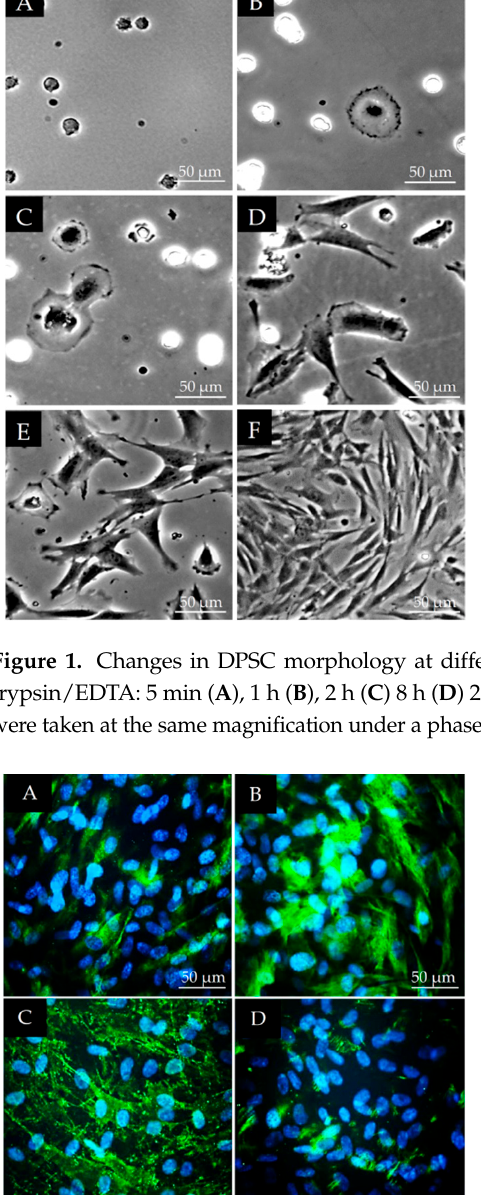
Figure 1. Changes in DPSC morphology at different stages of cell adhesion after passaging with trypsin/EDTA: 5 min ( A ), 1 hour ( B ), 2 hours ( C ) 8 hours ( D ) 21 hours ( E ) and 3 days ( F ). all of the photomicrographs were taken at the same magnification under a phase contrast microscope. The scale bars indicate 50 µm.